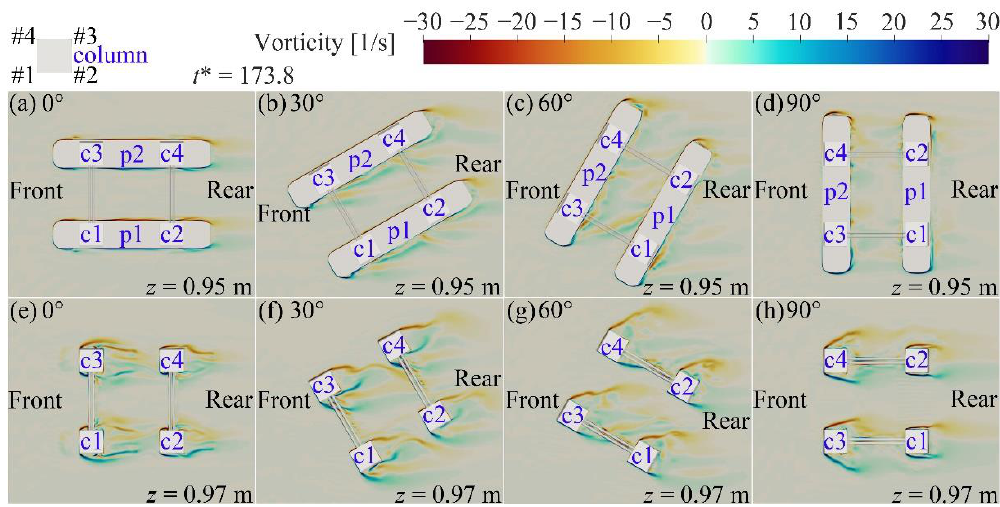
Figure 14. Comparison of the vorticity field around the semi-submersible platform at different angles at z = 0.95 m; z = 0.97 m. Water 2020 , 12 , x FOR PEER REVIEW